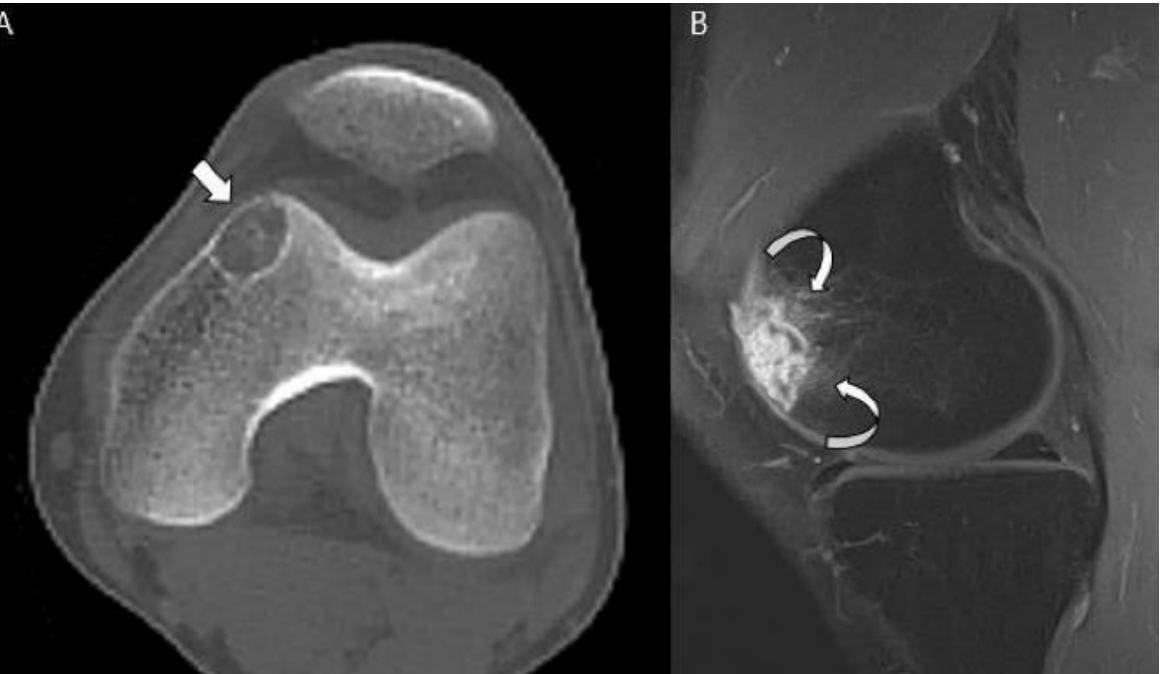
Figure 12. Clear cell chondrosarcoma of the distal femur in a 31-year-old man. ( A ) Axial CT scan shows an osteolytic lesion with a thin sclerotic margin at the distal femur (arrow). ( B ) Sagittal T1-weighted enhanced image with fat suppression shows a heterogeneously enhancing lesion with mild peritumoral enhancement at the distal femoral epiphysis (curved arrows).